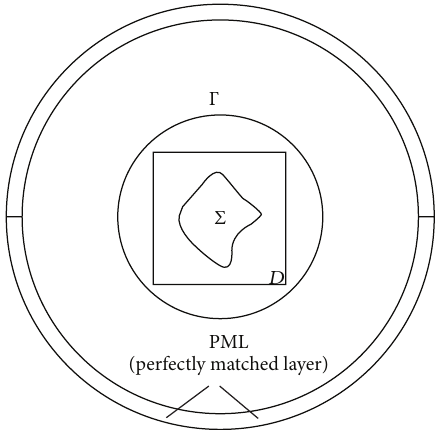
Figure 1: Sketch of the measurement setup used in COMSOL to simulate the total field data on the measurement curve Γ